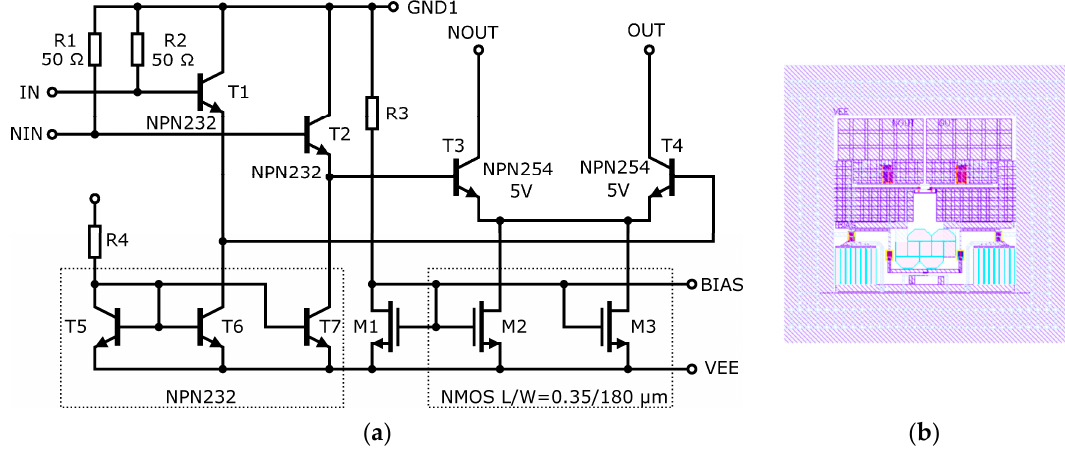
Figure 16. Proposed LCR driver circuit: ( a ) schematic diagram; ( b ) layout.